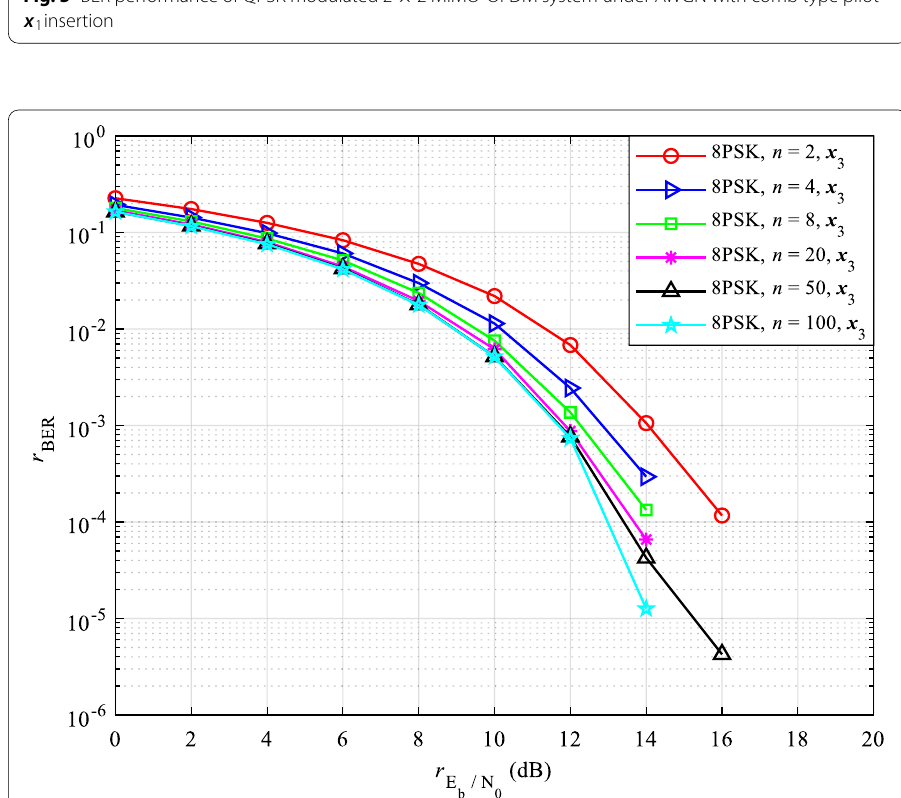
Fig. 6 BER performance of 8PSK modulated 2 x 3